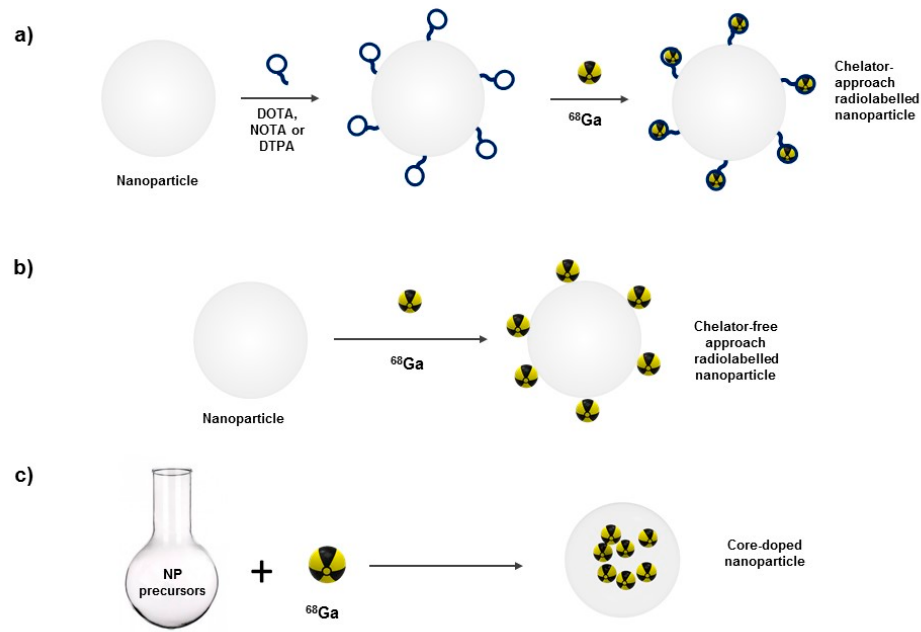
Figure 1. Nanoparticle radiolabeling approaches: ( a ) chelator approach; ( b ) chelator-free approach; and ( c ) nanoparticle core-doping. NP, nanoparticle; DOTA, 1,4,7,10-Tetraazacyclododecane-1,4,7,10-tetraacetic acid; NOTA, 1,4,7-triazacyclononane-1,4,7-trisacetic acid; DTPA, diethylenetriaminepentaacetic acid.